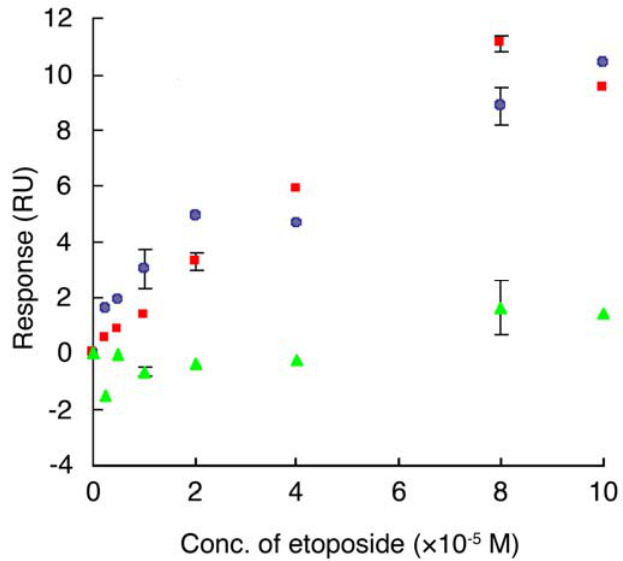
Figure 7. A plot of response (RU) obtained from SPR analysis between etoposide and protein. Various concentrations of etoposide (2.5, 5, 10, 20, 40, 80 and 100 μ M) were injected over the immobilized protein on the sensor chip and the corresponding response was recorded. Plots were generated by subtraction of the background signals generated simultaneously on the control flow cell (protein-non-immobilized cell), the injection of vehicle, and bulk response by DMSO. RU: resonance unit. 1 RU = 1 pg/mm 2 . ■ , etoposide and GST-E2F-4, ● , etoposide and top II, ▲ , etoposide and GST. Data are means ± S.D. of at least three independent experiments.